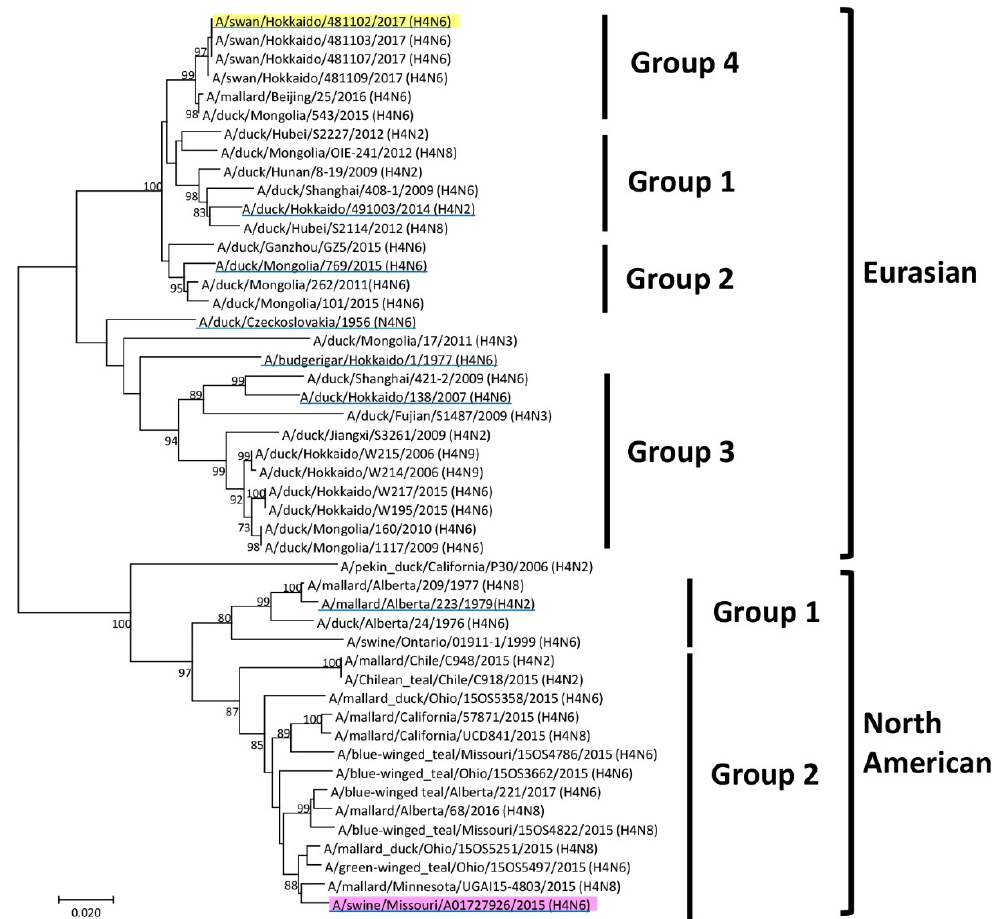
Figure 1. Phylogenetic tree of H4 hemagglutinin (HA) genes of influenza viruses. The nucleotide sequence of the HA gene segment was analyzed by neighbor joining using MEGA 7.0. The number on each node indicates the confidence level of the bootstrap analysis with 1000 replications. The Eurasian lineage was classified into Groups 1–4, and the North American lineage was classified into Groups 1 and 2. The vaccine strain is highlighted in yellow, and the challenging virus is highlighted in pink. The reference viruses used in the antigenic analysis are underlined in blue.